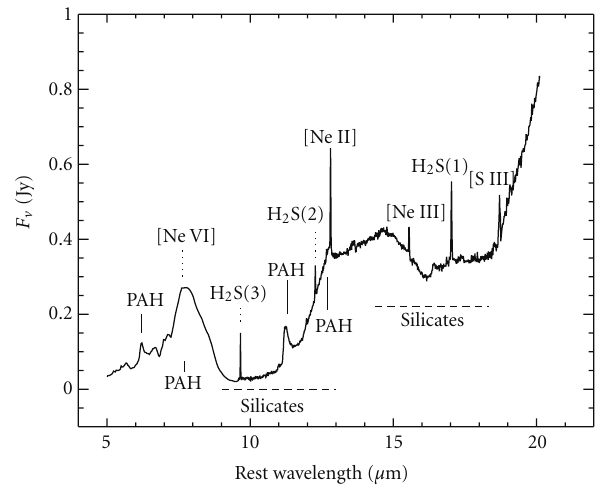
Figure 3: Spitzer /IRS 5–20 μ m emission. We have already analysed the low-resolution data in a previous work [11], while the high- resolution spectrum (above ∼ 10 μ m) has been extracted from the same dataset following Schweitzer et al. [4]. The main features are labelled for ease of